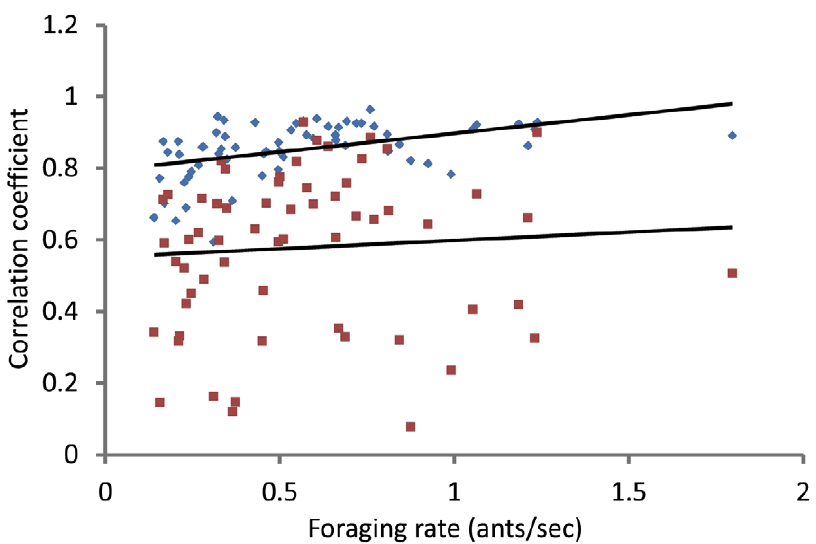
Figure 3. Correlation of rates of outgoing and returning foragers as a function of level of foraging activity. Each point shows, for one trial, the coefficient of correlation between the smoothed rates of returning and outgoing foragers. The x-axis shows the mean rate of returning foragers over the entire trial. Blue diamonds show the coefficients of correlation between observed rates of returning foragers and simulated rates of outgoing foragers. Red squares show the coefficients of correlation between observed rates of returning foragers and observed rates of outgoing foragers. The upper line shows the least-squares fit to the increase with foraging activity of the correlation between observed returning and simulated outgoing foraging rates points (blue); the lower line shows the least-squares fit to the increase with foraging activity of the correlation between observed returning and observed outgoing foraging rates(red).